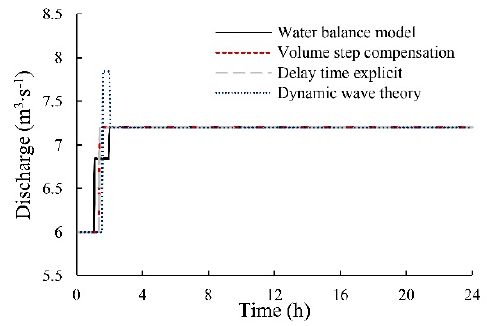
Figure 5. Simulation process of canal pool discharge.